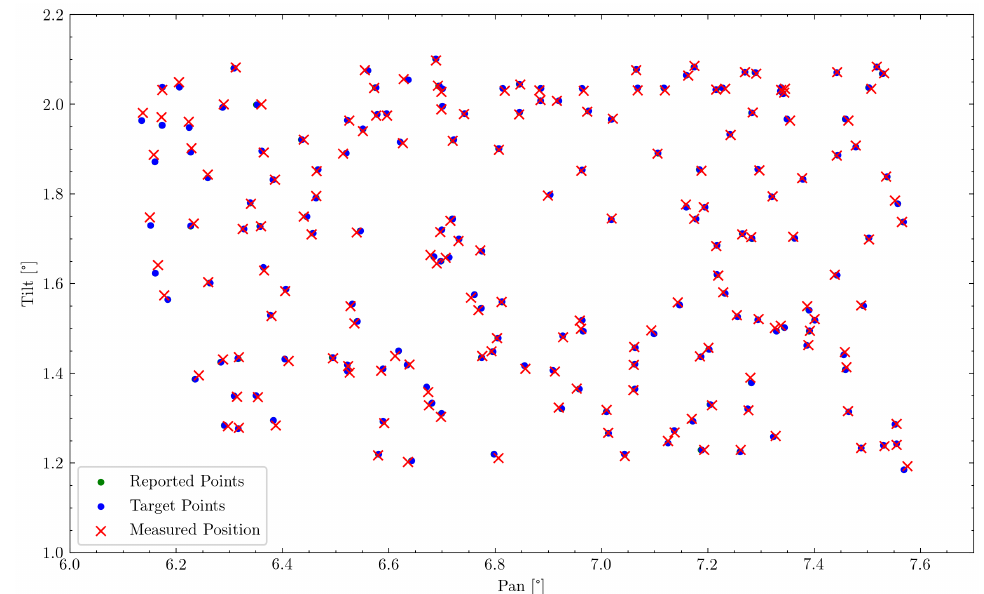
Figure 9. Representation of commanded (blue) and reported (green) to measured (red) pointing position. Due to good motor controls, the reported position is nearly always covered by the com- manded position.